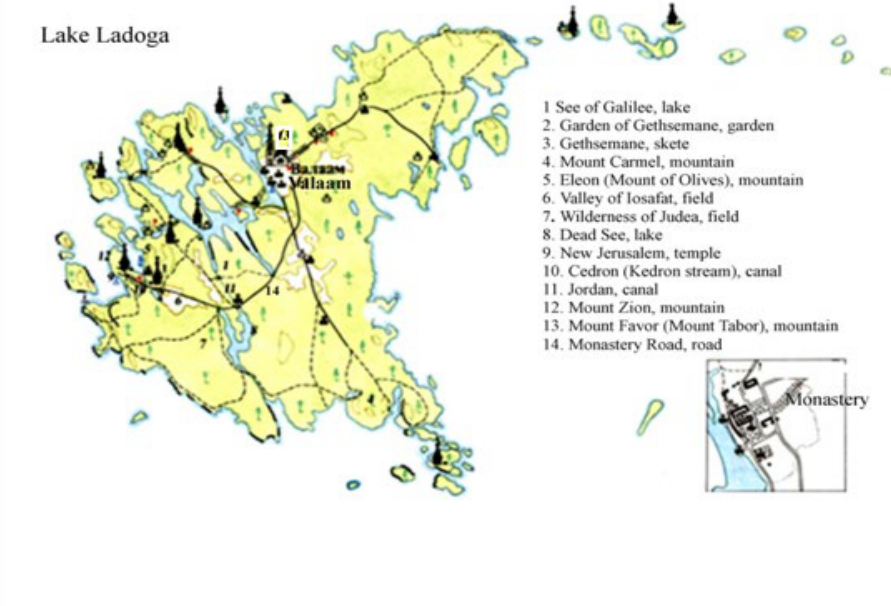
Figure 1. – New Jerusalem on